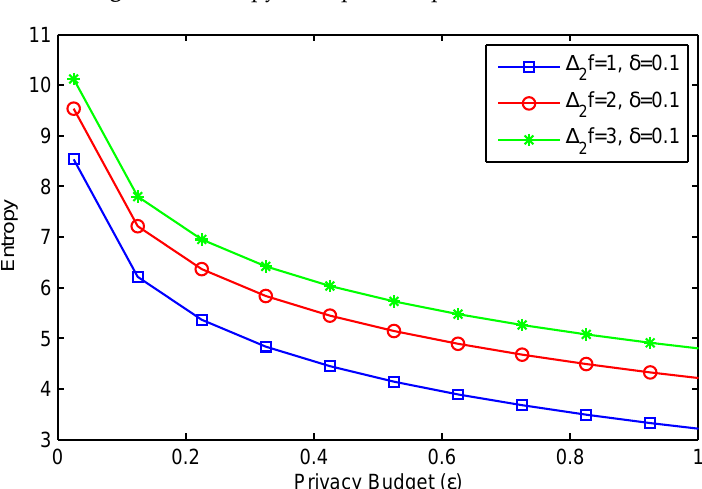
Figure 14. Entropy of output of Laplace mechanism.